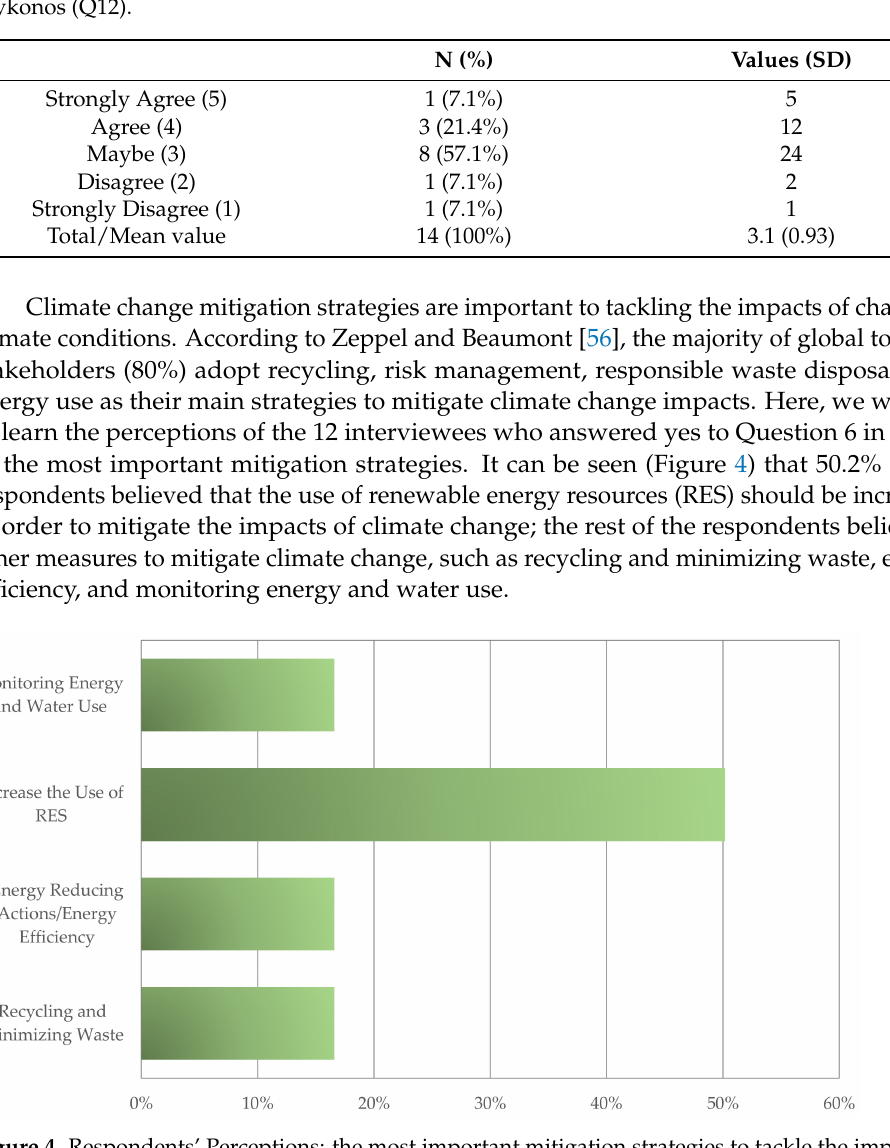
Figure 4. Respondents’ Perceptions: the most important mitigation strategies to tackle the impacts of climate change